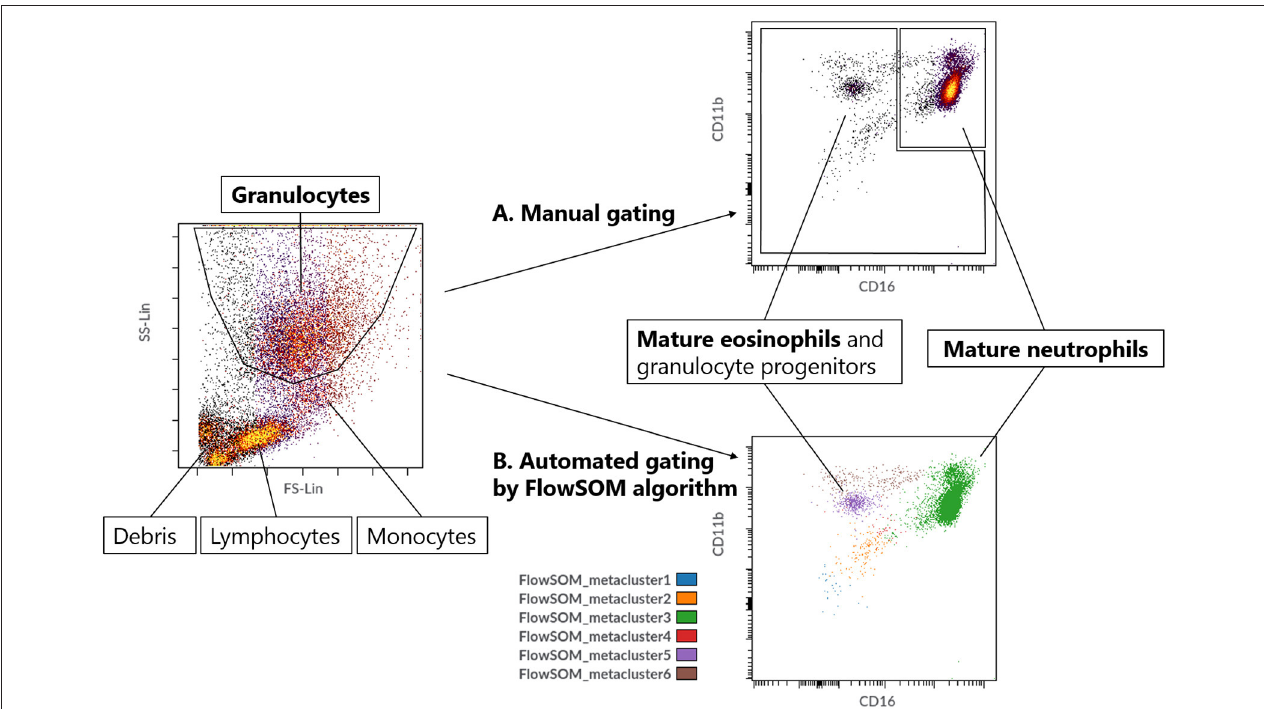
FIGURE 2 | (A) Manual gating strategy for mature neutrophils. (B) Automated gating strategy for mature neutrophils (metacluster 3) and eosinophils (metacluster 5) by using the FlowSOM algorithm with 64 clusters and 6